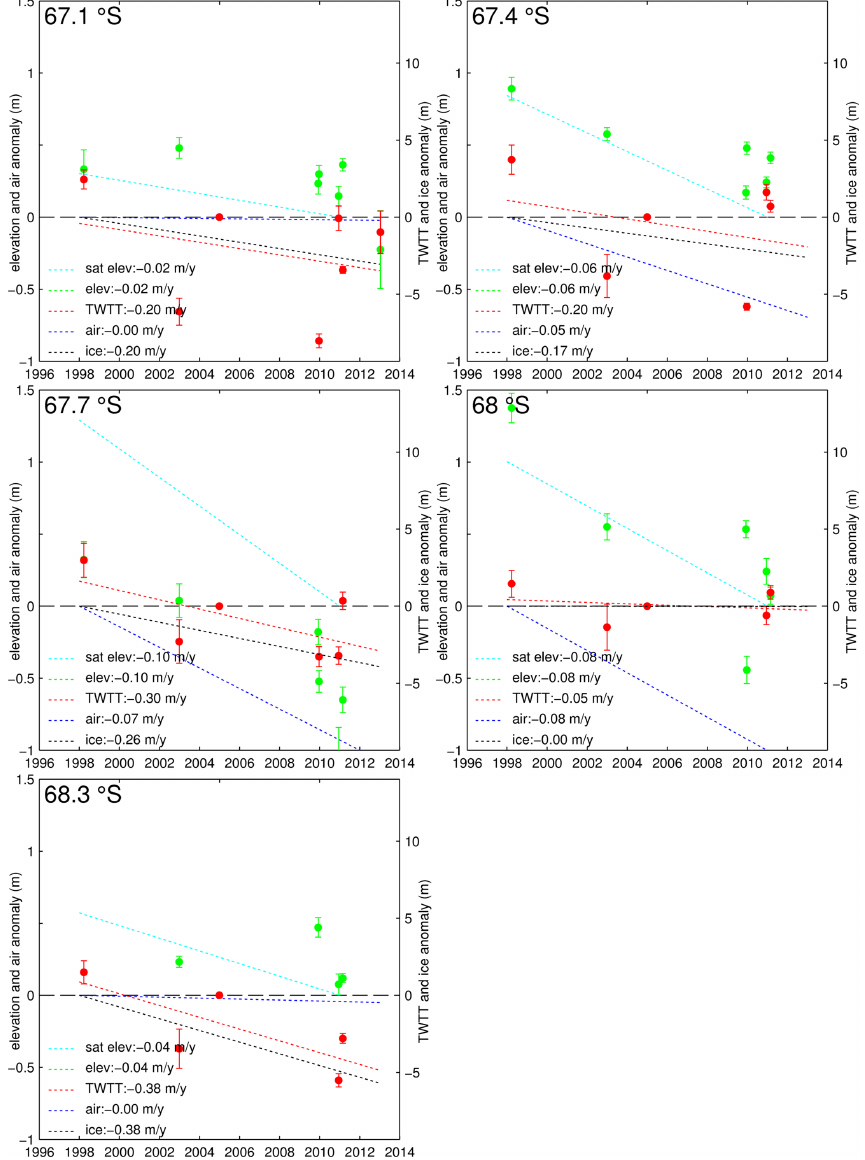
Figure 6. Data and trends for the five latitude bins defined by the satellite altimetry crossovers, labelled with the latitude of the accompanying crossover. Data points show the mean and 95% confidence intervals of the differences between each survey and the 2004 baseline for surface elevation (green) and TWTT (red, expressed as solid-ice equivalent). The satellite-altimeter-derived elevation trend for the crossover at the centre of each bin is also shown (cyan). Surveyed trends in elevation and TWTT are converted to trends in ice (black) and air (blue) thickness. Elevation and air thickness are plotted on the left-hand axis, while TWTT and ice thickness are plotted such that the right-hand axis shows absolute values and the left-hand axis shows the equivalent surface